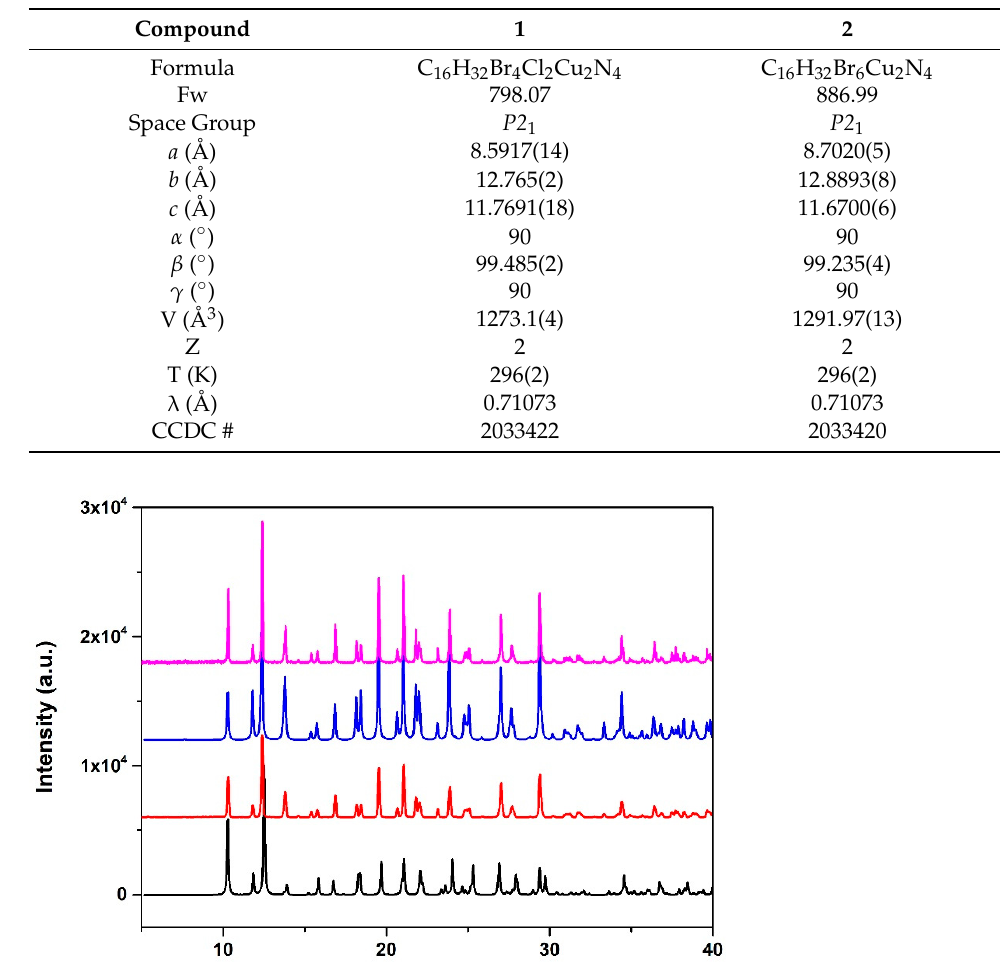
Table 1. Single crystal X ‐ ray diffraction data of compounds 1 and 2 .